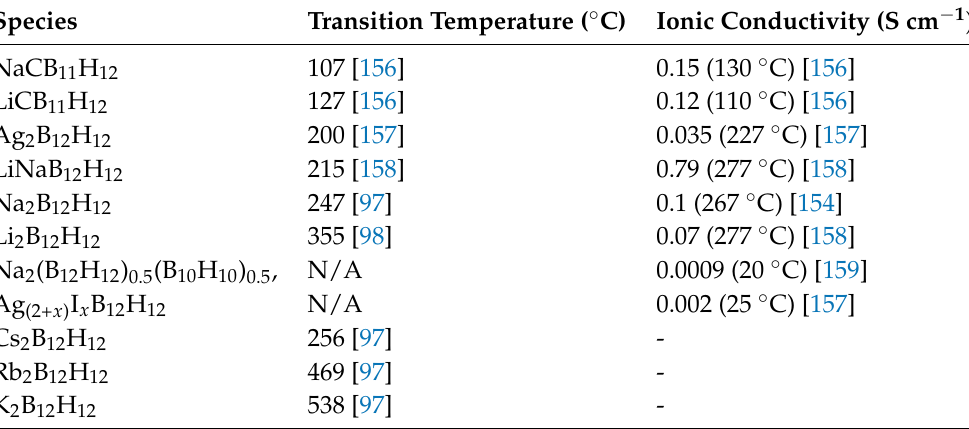
Table 7. Tabulated values for the order–disorder transition temperature and the ionic conductivity reported at a given temperature for a selection of dodecaborates and dodecaborate